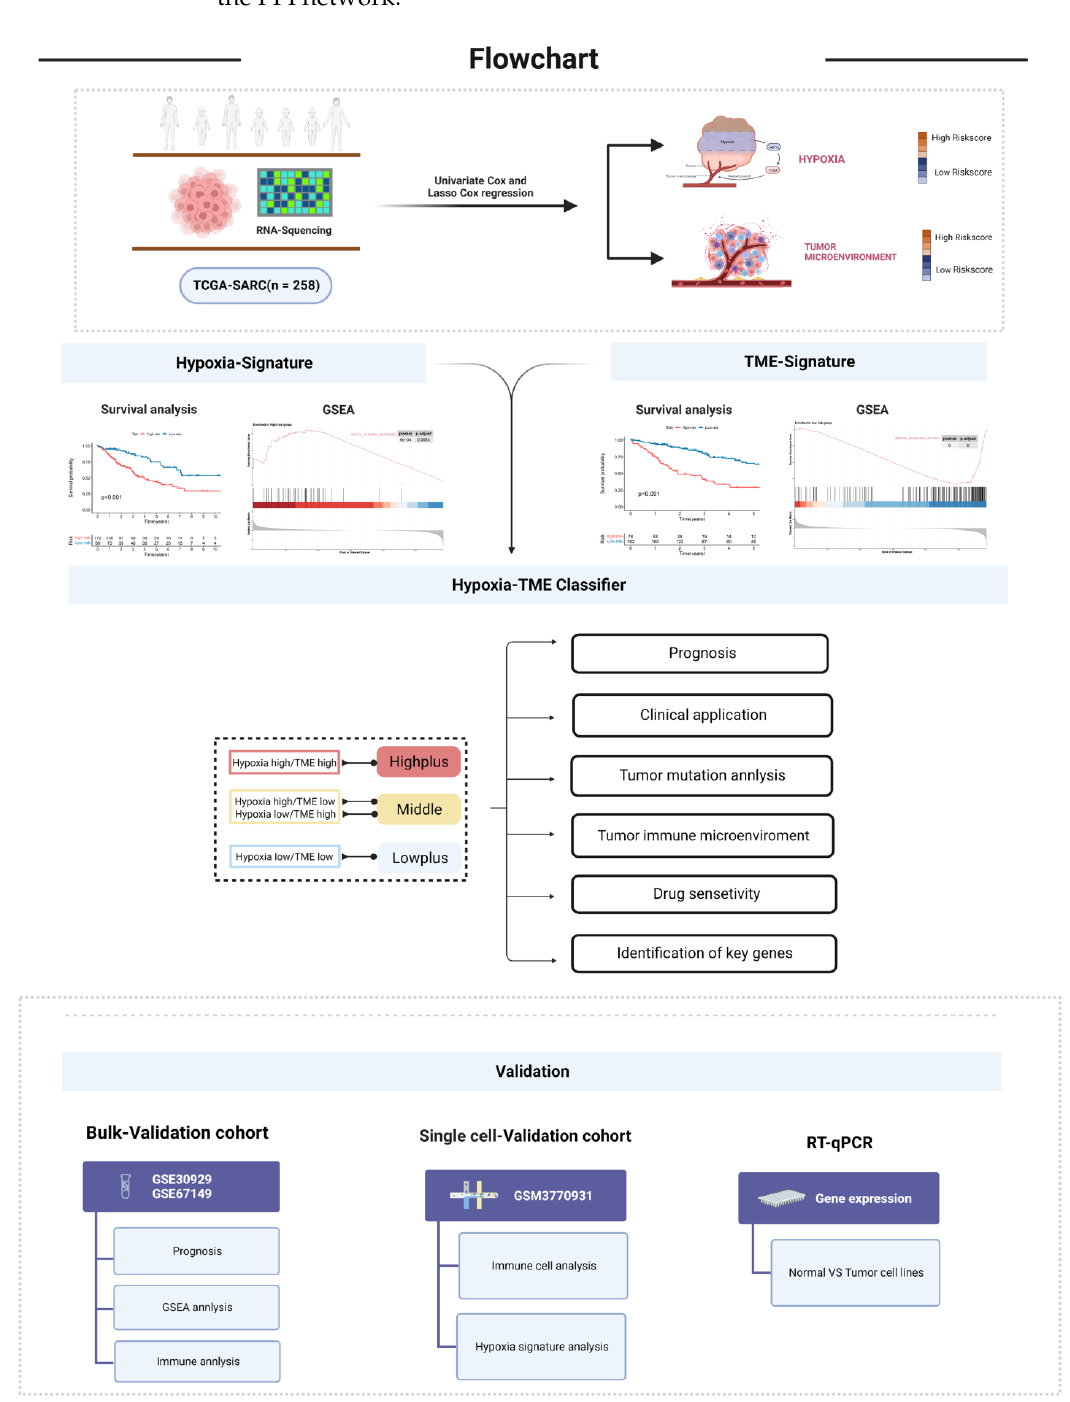
Figure 1. Flow chart of the work process.